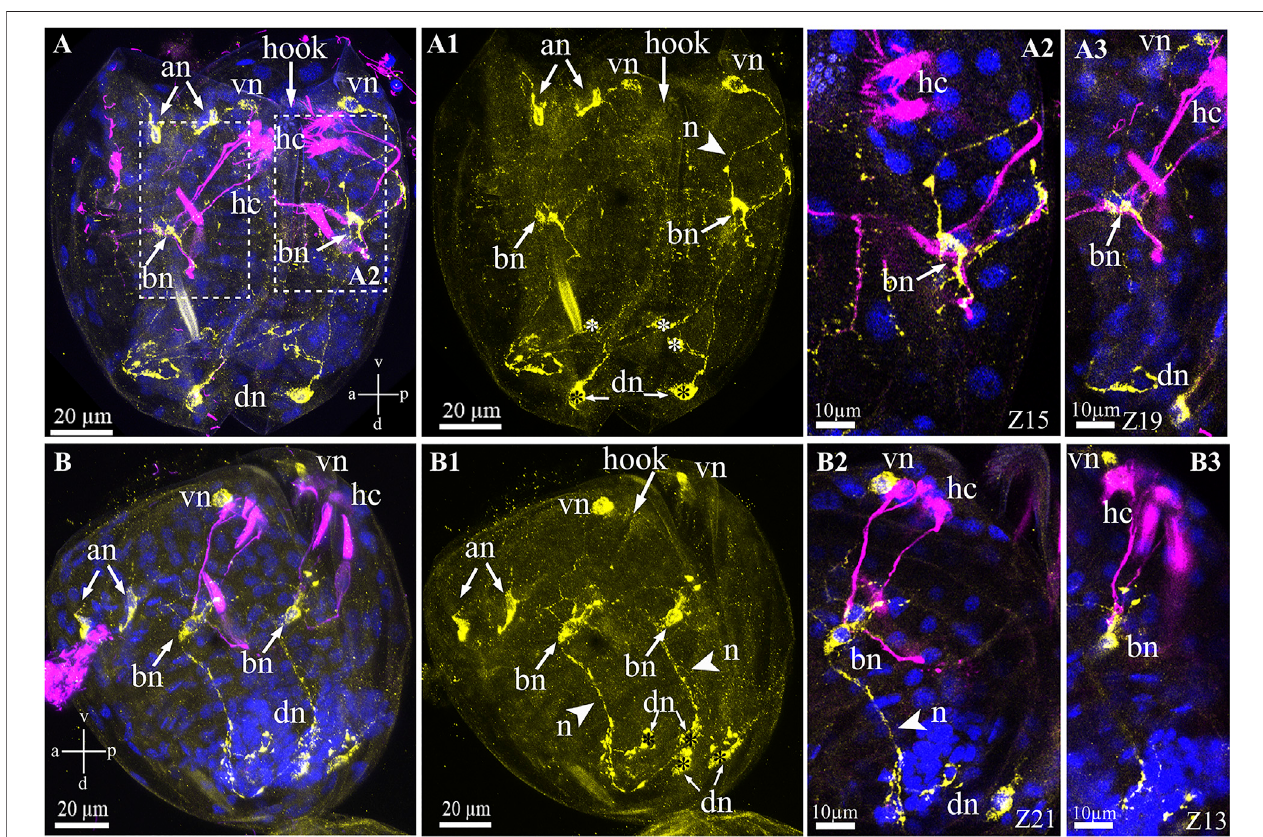
FIGURE 7 | FMRFamide-like immunoreactivity (FMRFa-lir) in the Nodularia douglasiae glochidia. (A,A3) posterior view; (B – B3) lateral view. Yellow — FMRFa-lir; magenta — hair cells, acetylated tubulin immunoreactivity; blue — nuclei, DAPI. (A,A1,B,B1) FMRFamidergic nervous system larvae consist of paired anterior, ventral, dorsal, and basal neurons (arrows). The latter communicate both with ventral and dorsal neurons via neurites. Paired anterior neurons do not contact other neurons or haircellsofglochidia. (A2,A3,B2,B3) Highmagni fi cationofcontactshaircells,basalcells,andventralneurons.Theinsertshowsthatbasalcellsaredouble-positive for FMRFamide and acetylated tubulin (arrows). (A,B) Vertical v-d labelled line refers to ventro-dorsal body axes and horizontal line a-p labelled line refers to anterior- posterior body axes of larva. Abbreviations: an, anterior neurons; bn, basal neurons; dn, dorsal neurons; hc, hair cells; n, neurites; vn, ventral neurons; Scale bars, (A,A1,B,B1) , 20 μ m; (A2,A3,B2,B3) , 10 μ